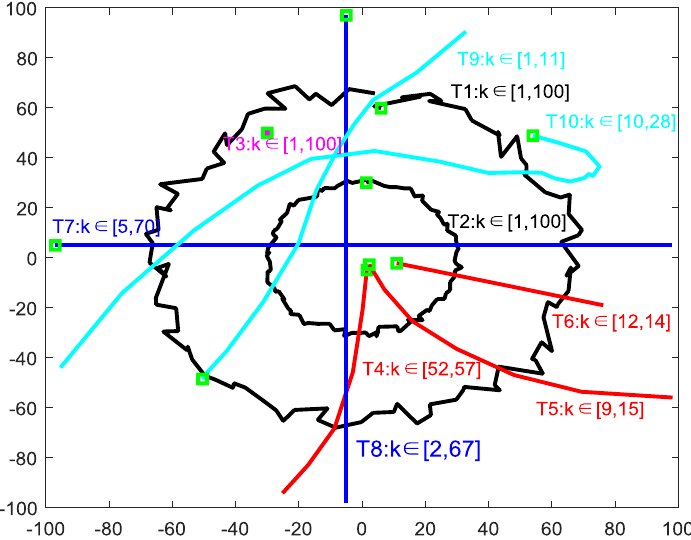
Figure 7. Trajectories of the targets with a fully unknown movement.